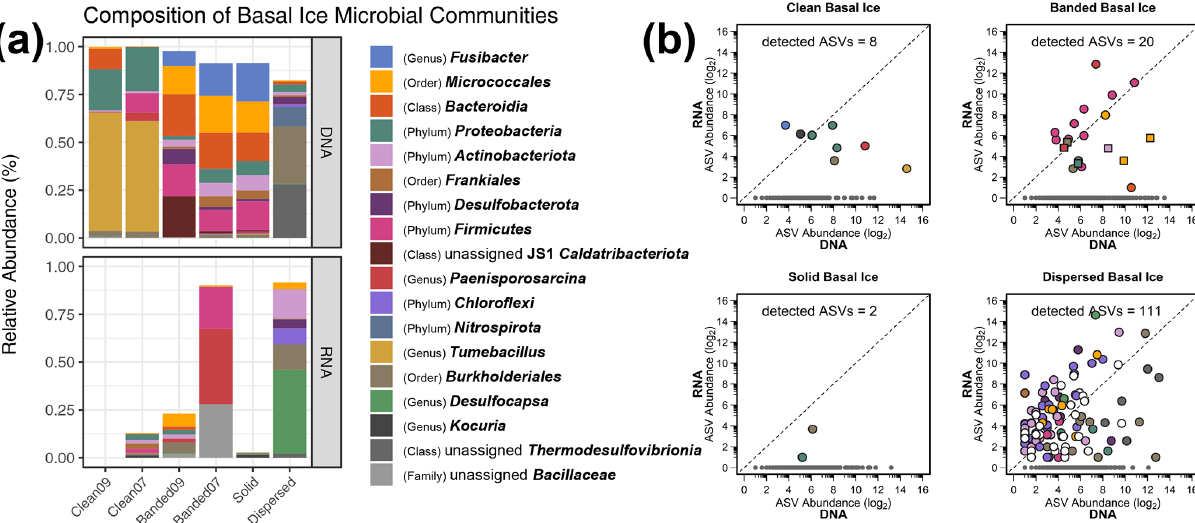
Figure 1. (a) Relative abundances of microbial lineages observed in basal ice based on the use of DNA and RNA templates for detecting 16S rRNA sequences. The graph displays the highest-resolution classification for the most abundant taxa and was constructed as follows. First, ASVs were clustered by genus, and any ASVs having a relative abundance ≥ 20% in at least one of the samples were plotted. This procedure was subsequently repeated with the remaining unplotted ASVs at the rank of family, order, class, and finally phylum. Any remaining rare taxa left after this procedure were not plotted. The bottom plot was scaled to reduce inflated relative abundance biases introduced during curation. (b) Scatter plots of potentially active ASVs within four types of basal ice. Each point represents an individual ASV. The dotted line indicates a 1 : 1 ratio between the RNA- and DNA-based 16S rRNA libraries. Gray points denote ASVs observed only in the DNA-based libraries. In the banded basal ice plot, circles denote ASVs from the Banded07 sample, while squares denote ASVs from the Banded09 sample. “Detected ASVs” in each plot denotes the number of ASVs observed in both the RNA- and DNA-based 16S rRNA libraries.